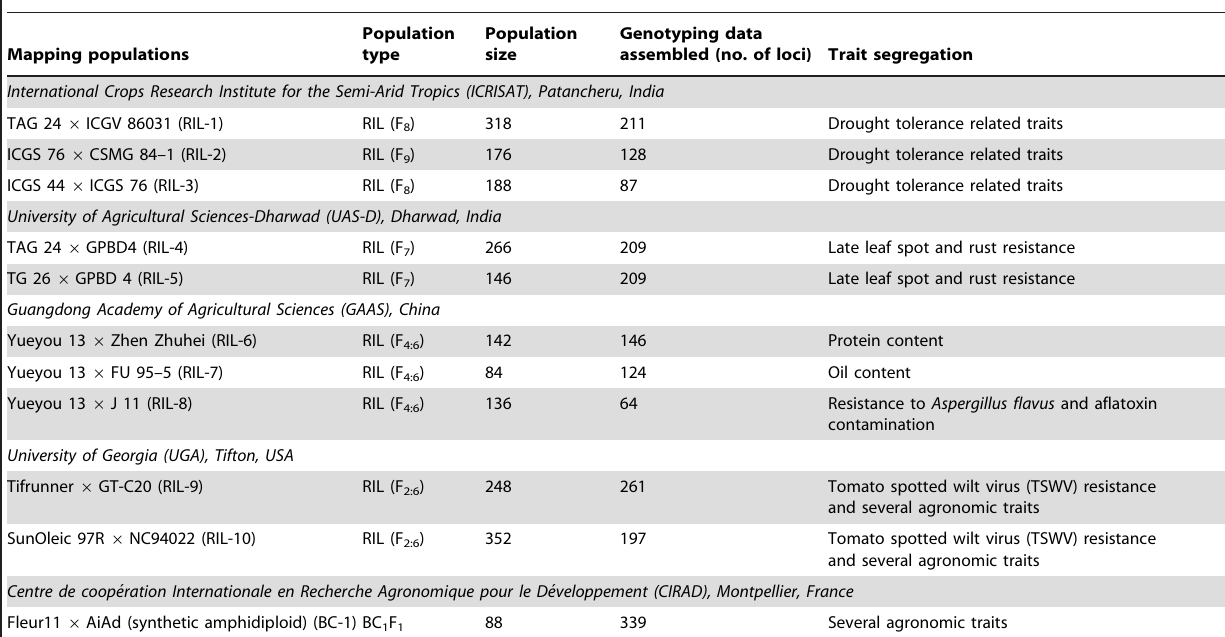
Table 1. Source of marker data used for constructing the reference consensus genetic map.